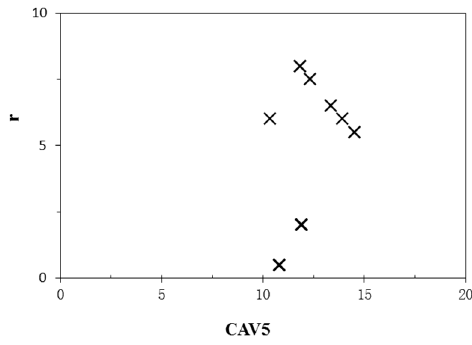
Figure 4. r versus CAV 5 for 6.4 ≤ M w < 7 of the main dataset applied in this study.